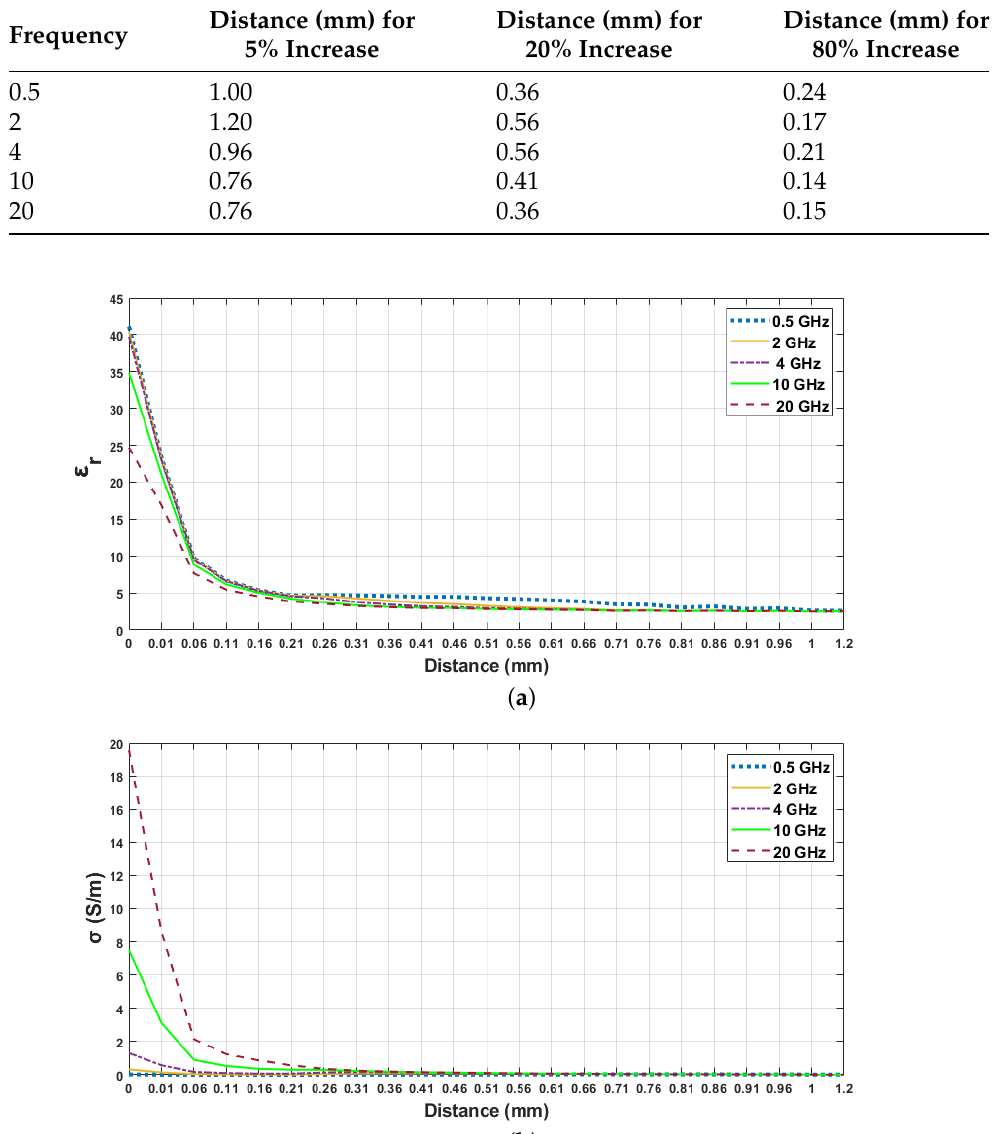
Table 5. Distances at the specified thresholds for simulated skin–triton X-100 configuration at 0.5, 2, 4, 10 and 20 GHz frequency points.